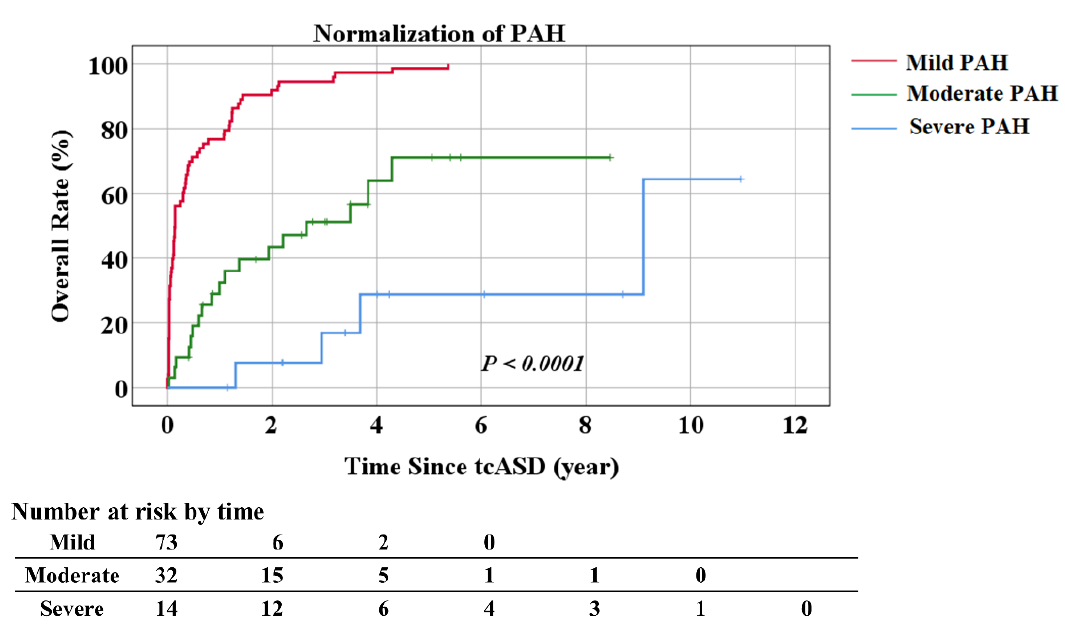
Figure 3. Kaplan–Meier curves showing the cumulative rate of normalization of PAH according to pulmonary arterial systolic pressure. PAH, pulmonary arterial hypertension; tcASD, transcatheter closure of atrial septal defect.